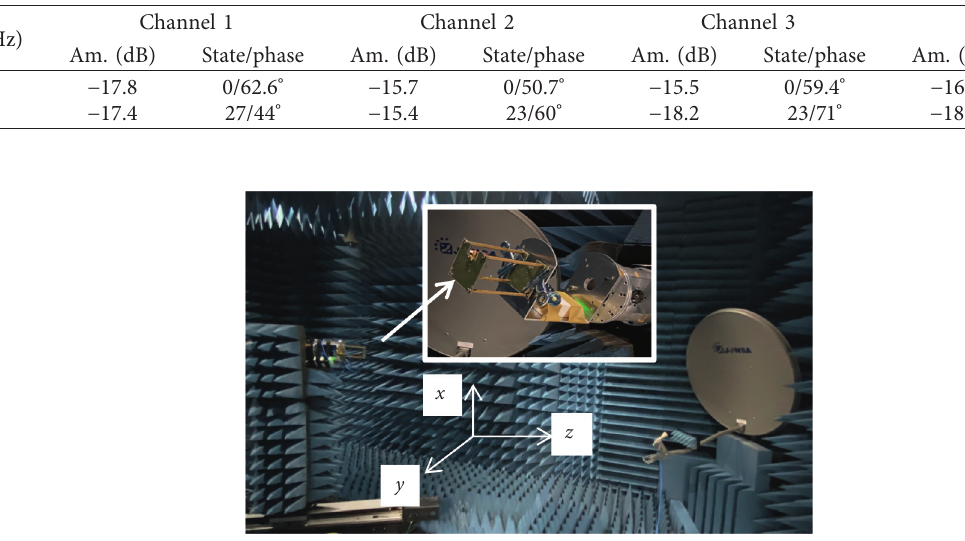
Figure 7: OTA measurements in CATR chamber at Oriental Institute of